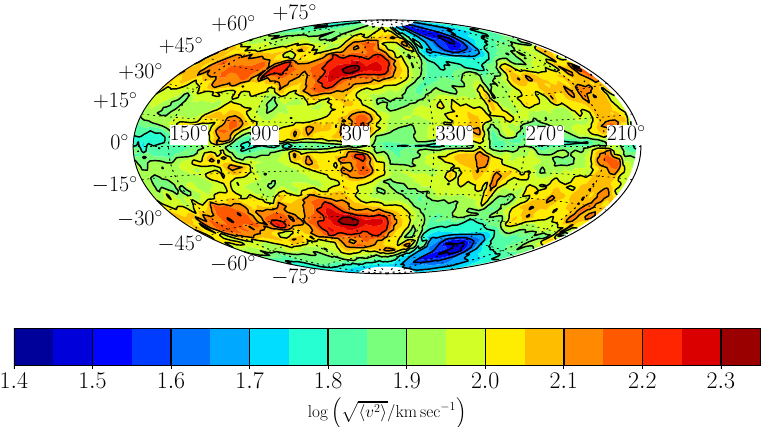
Figure 4. The average speed of the outflow at a spherical shell of radius 4 AU for a simulation with spiralling-in orbit with jets velocity of 400 km s − 1 and jets half-opening angle of 30 ◦ . Zero latitude is the equatorial (orbital) plane and zero longitude (at the center) is the initial location of the companion. The companion is moving towards higher angles, namely from the right to the